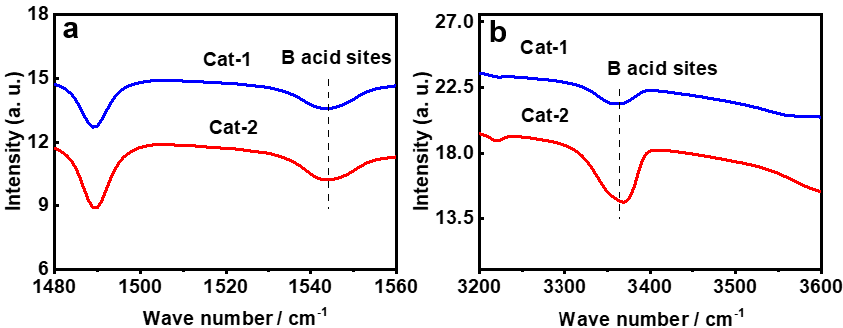
Figure 5. Py-FTIR ( a ) and DTBPy-FTIR ( b ) for prepared FCC catalysts.